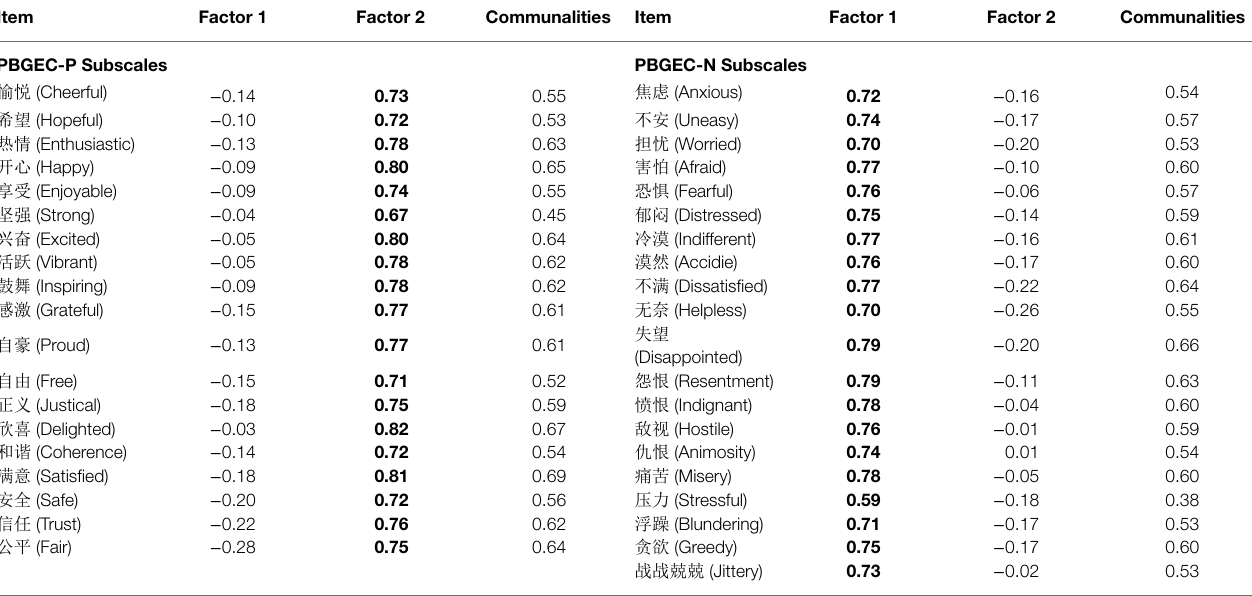
TABLE 3 | Factor loading matrix for exploratory factor analysis of the PBGECS-39.